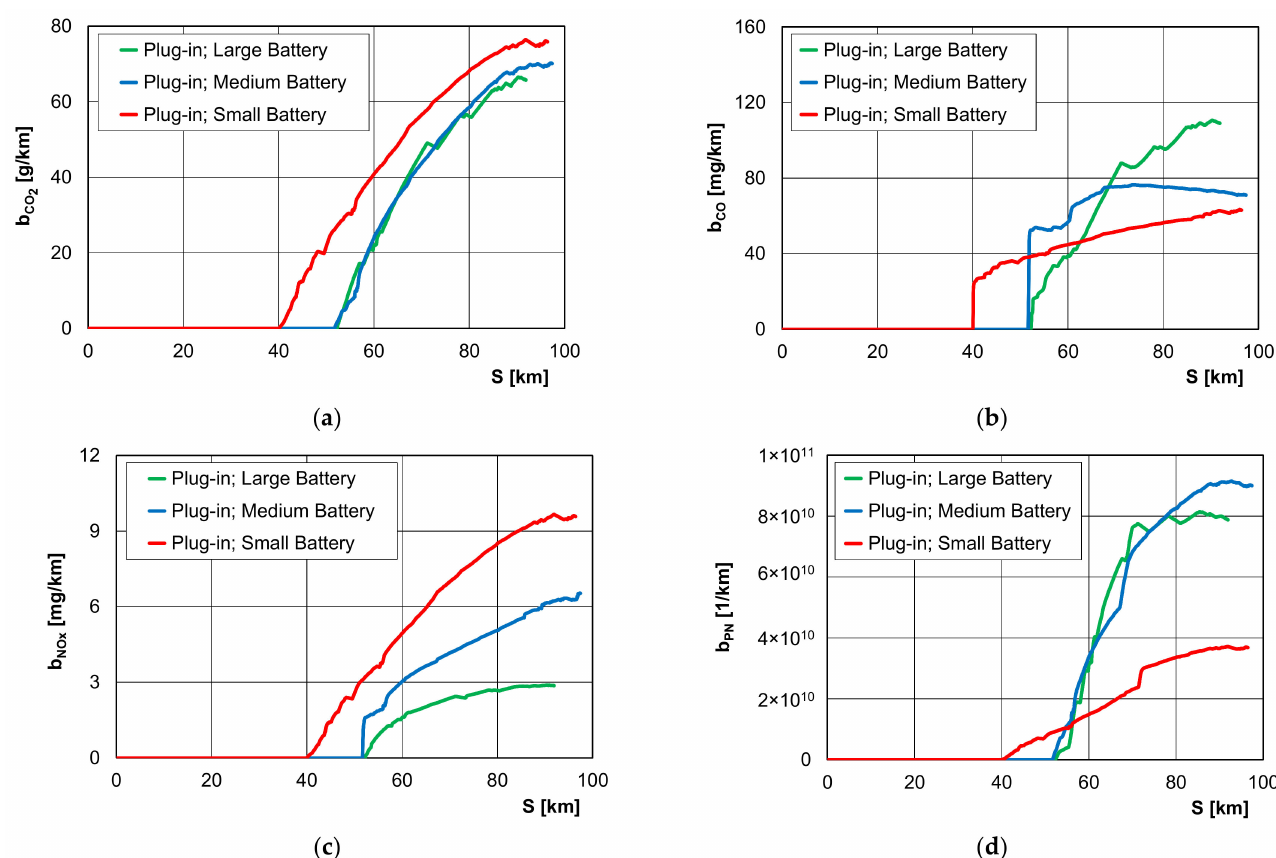
Figure 5. Dependence of the emission of carbon dioxide ( a ), carbon monoxide ( b ), nitrogen oxides ( c ), and particle number ( d ) on the distance covered during the road tests for individual investigated vehicles; the curves were made using the emission intensity results obtained in each second of the